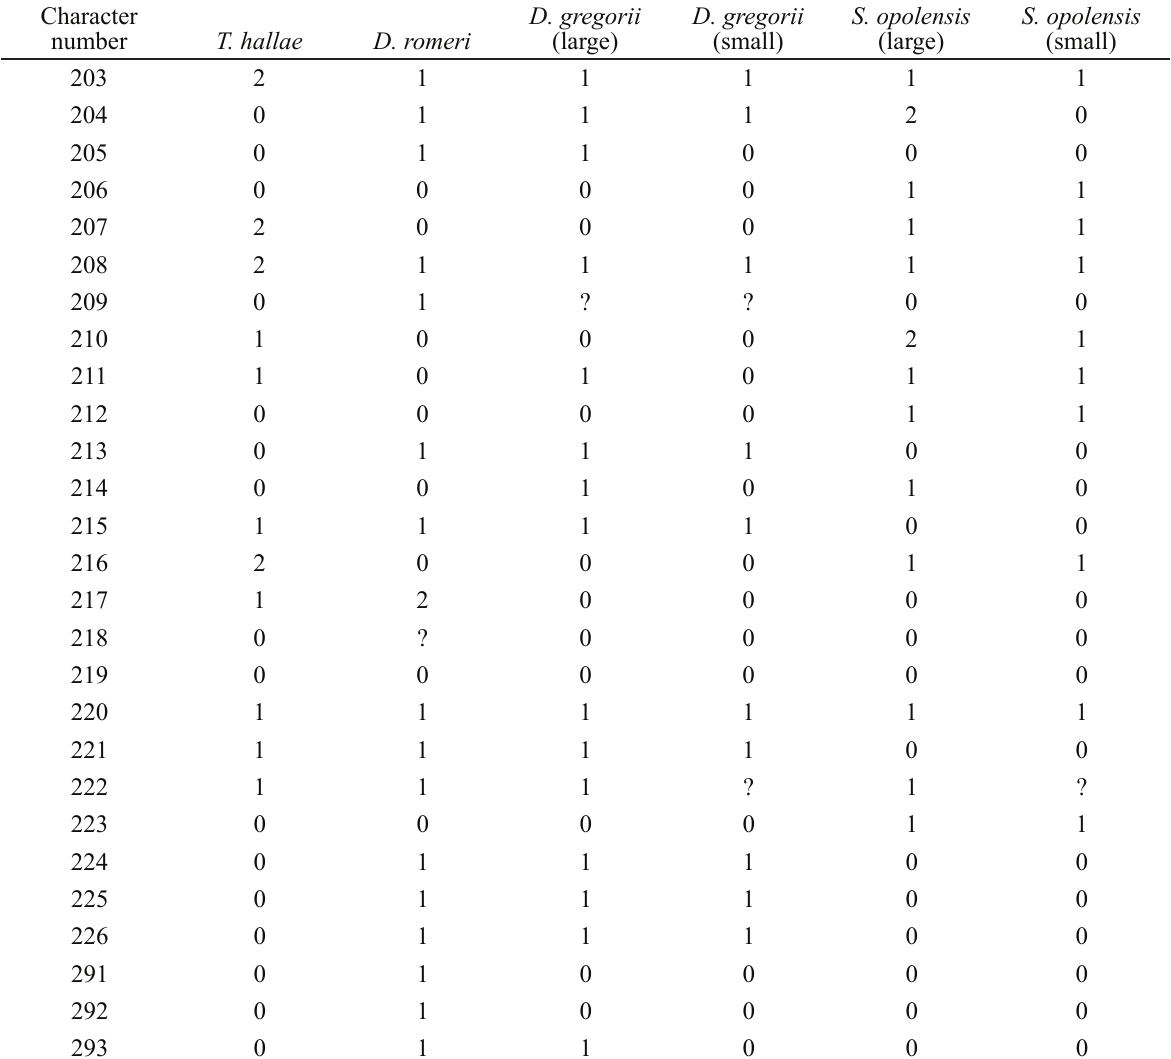
Codification for the specimens evaluated in the disparity quantification of the 27 femoral characters of Martínez et al . (2016). Character